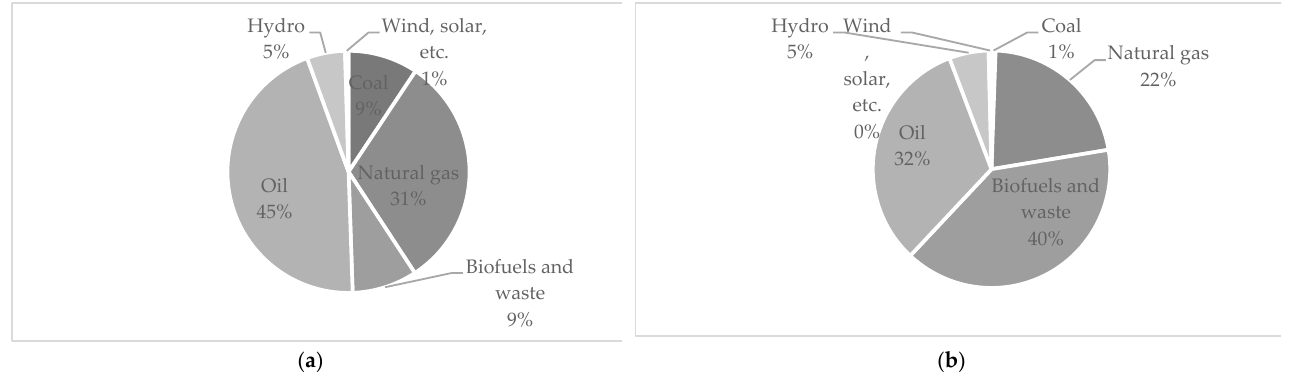
( b ) Figure 7. Structure of energy supply in Lithuania: ( a ) 1990; ( b ) 2020. Source: authors’ compilations based on database of the International Energy Agency. Figure 7 describes changes in the structure of the energy supply in Lithuania from 1990 to 2020. Considering Lithuania closed its last nuclear reactor in 2009, this energy source is not available anymore. However, its share of biofuels and waste has increased from 2% into 23%. As a path towards sustainable energy, its share of wind, solar, and hydro is increasing. However, this is still irrelevant as renewables constitute just 3% of the total energy supply. A positive development towards sustainability is reduction of the proportion of coal energy from 5% to 2%. However, Lithuania is still significantly depend- ent on oil (42%) and natural gas (30%).